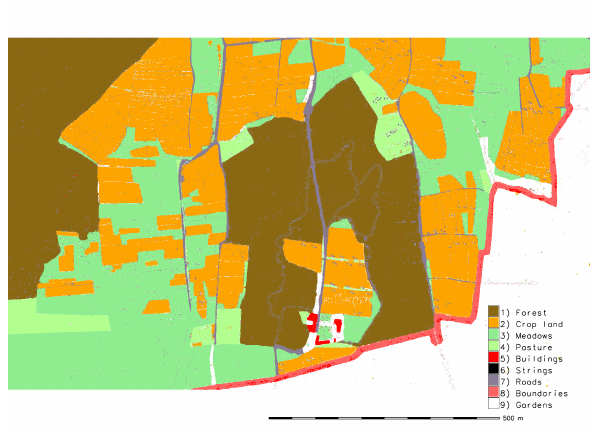
Figure 10. Classified map for contextual supervised MLC after text and symbols removal - particular. Results for the 3 MLC classifiers and 4 voting systems for OBIA are reported in tab 3.